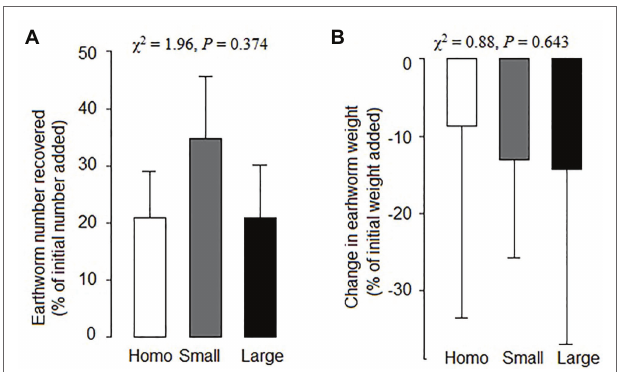
FIGURE 5 | Changes in number (A) and freeze-dry weight (B) of earthworms in the homogeneous, heterogeneous large patch and heterogeneous small patch treatments. Mean ± SE ( n = 6) and χ 2 and values of p of Kruskal–Wallis rank test are